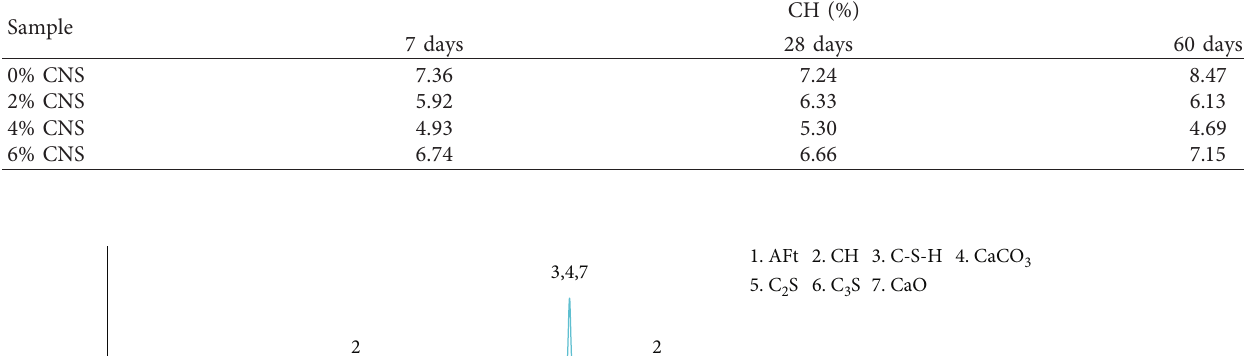
Table 4: CH content of samples with different CNS content by thermogravimetric analysis.